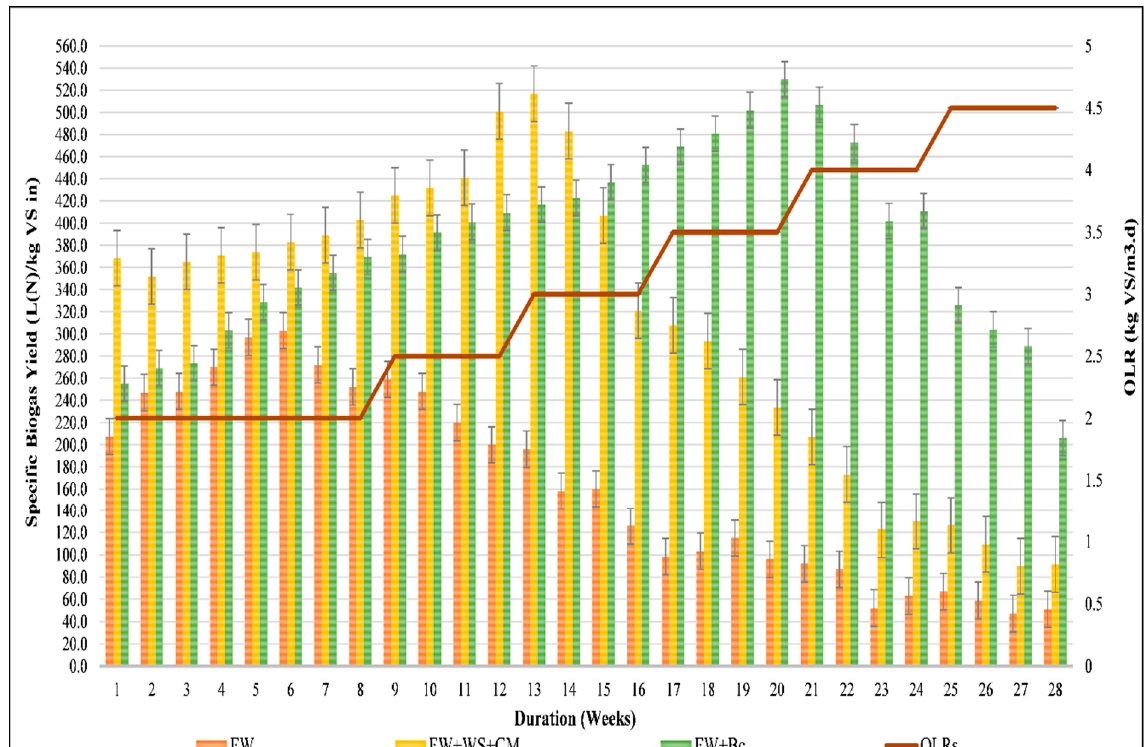
Figure 5. Specific biogas yields of different mixtures at different OLRs. Table 4. Anaerobic process performance indicators during OLR variation (mean ± standard deviation (SD)). Feedstock